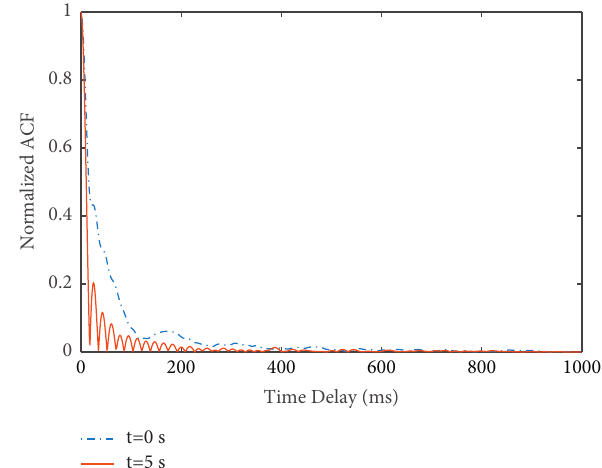
Figure 6: The normalized ACFs of the scattering